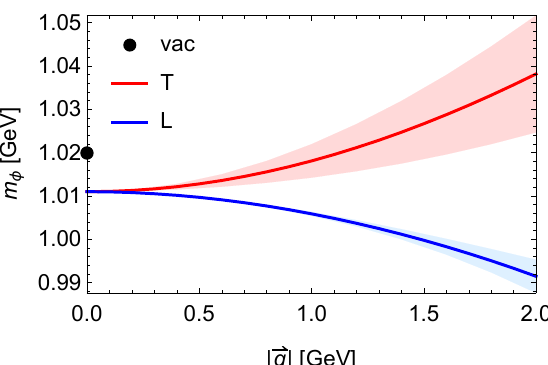
Figure 1. The ϕ meson pole mass, shown as a function of momentum j ⃗ q j for longitudinal (blue curve) and transverse (red curve) modes, at normal nuclear matter density (cid:26) 0 . Adapted from